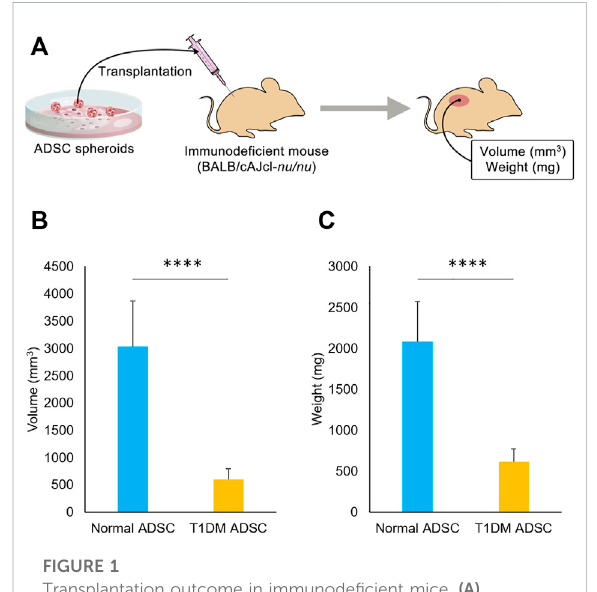
FIGURE 1 Transplantation outcome in immunode fi cient mice. (A) Diagram showing transplantation of ADSCs spheroids to immunode fi cient mice. (B) Graftvolume(mm 3 )2 weeksafter stem cell transplantation. (C) Graft weight (mg) 3 weeks after stem cell transplantation. Three independent experiments were performed for the assay. (B) The p -value was < 0.0001. (C) The p -value was < 0.0001. Normal ADSCs and T1DM ADSCs were seeded at a density of 6000 cells/cm 2